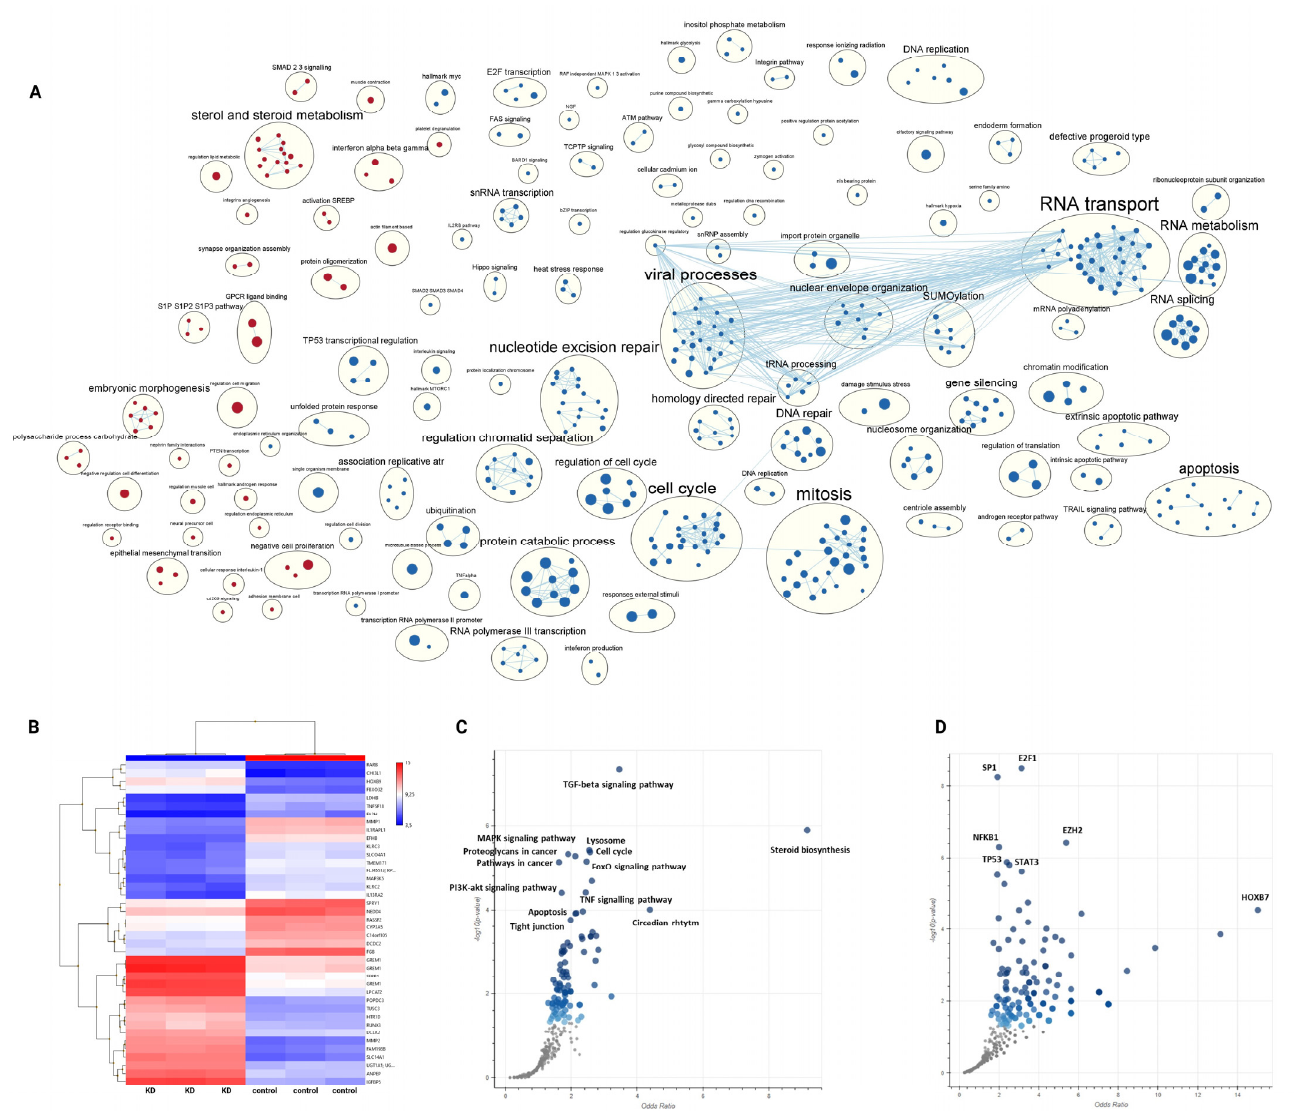
Figure 5. Knockdown of hsa_circ_0062682 in SNU-449 cell line induces profound changes on the transcriptomic level. ( A ) Pathway enrichment analysis of upregulated (red colour) and downregulated (blue colour) pathways. Each node (circle) represents a pathway and edges represent shared genes by the connected pathways. Annotations of clusters of similar pathways representing major biological themes are provided above clusters; ( B ) heatmap of top 20 most upregulated and top 20 most downregulated genes in a stable KD of hsa_circ_0062682 in SNU-449 cell line, heatmap legend consists of log2 transformed expression values; ( C ) volcano plots from Enrichr analysis of enriched gene sets in KEGG pathways and in ( D ) the TRRUST database of transcription factors, made by Appyter. Blue dots represent significantly enriched gene sets, grey dots represent not enriched gene